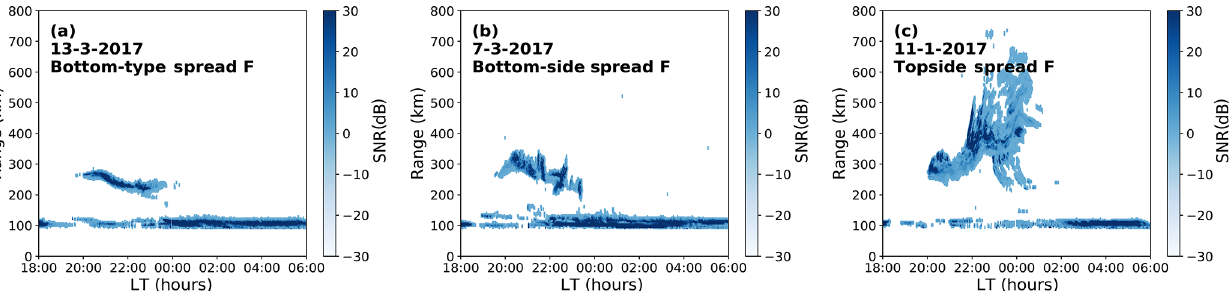
Figure 2. Examples of the different types of ESFs that may be observed by the JULIA radar. The colour bar presents the signal-to-noise ratio (SNR) in decibels